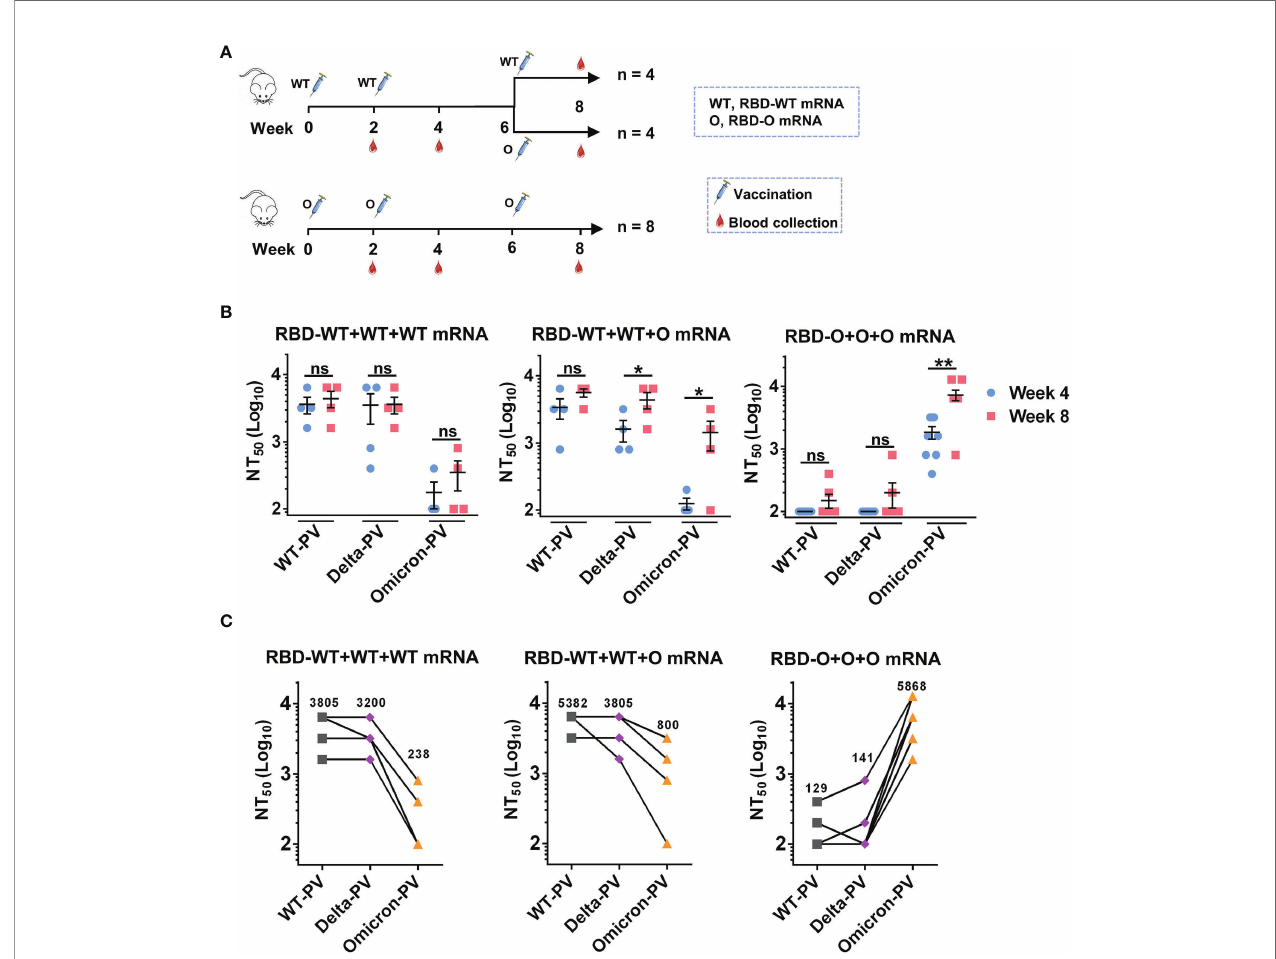
FIGURE 3 | The in fl uence of homologous and heterologous booster immunization programs on serum neutralization titers and breadth. (A) Mice booster immunization schedule. The original RBD-WT mRNA vaccine group was divided into two (n = 4 mice per group): group I (the RBD-WT+WT+WT mRNA group) mice were boosted with the RBD-WT mRNA vaccine, and group II (the RBD-WT+WT+O mRNA group) mice with the RBD-O mRNA vaccine. The original RBD-O mRNA vaccine group (re- named the RBD-O+O+O mRNA group) received a third dose of the RBD-O mRNA vaccine. Serum samples were collected at week 8. (B) Neutralizing titers of the week- 4 and week-8 antisera samples from each group against WT-, Delta-, and Omicron-PV (pseudovirus). If serum samples show less than 50% neutralization at the 1:200 dilution, a NT 50 value of 100 was assigned for statistical analysis. ns, not signi fi cant; * p < 0.05; ** p < 0.01. (C) Neutralizing titers of the week-8 antisera from the three vaccine groups against SARS-CoV-2 PVs. The geometric mean of NT50 values was